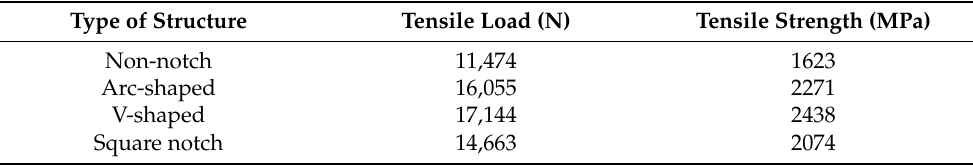
Figure 6. Tensile loads of four bolt structures. Table 3. Comparison of tensile load and tensile strength of four structures.